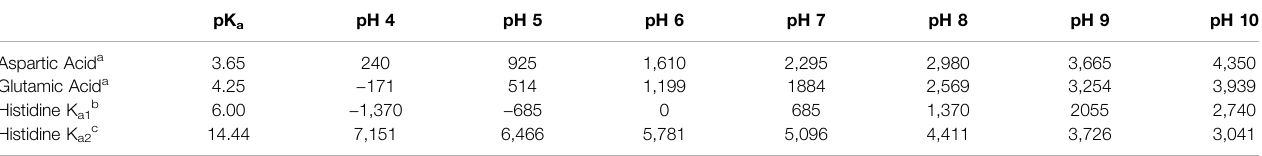
TABLE 1 | Energy costs in HINT scores for computational titration of aspartic acid, glutamic acid and histidine at various pH values. pK